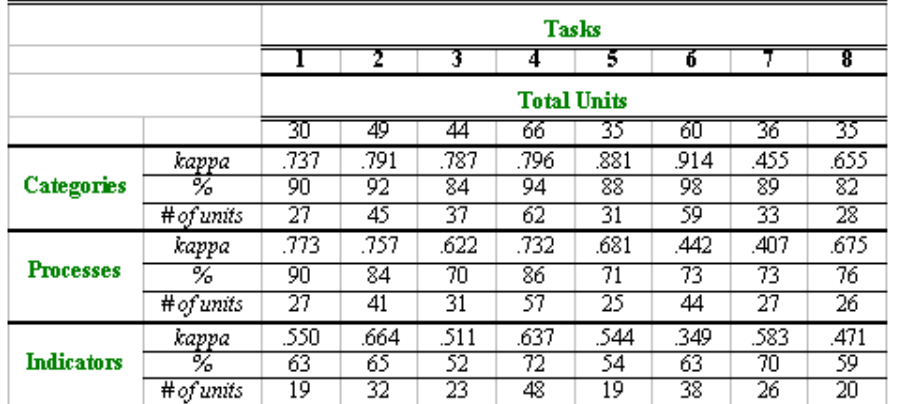
Table 2. Summary of Differences in Agreement across